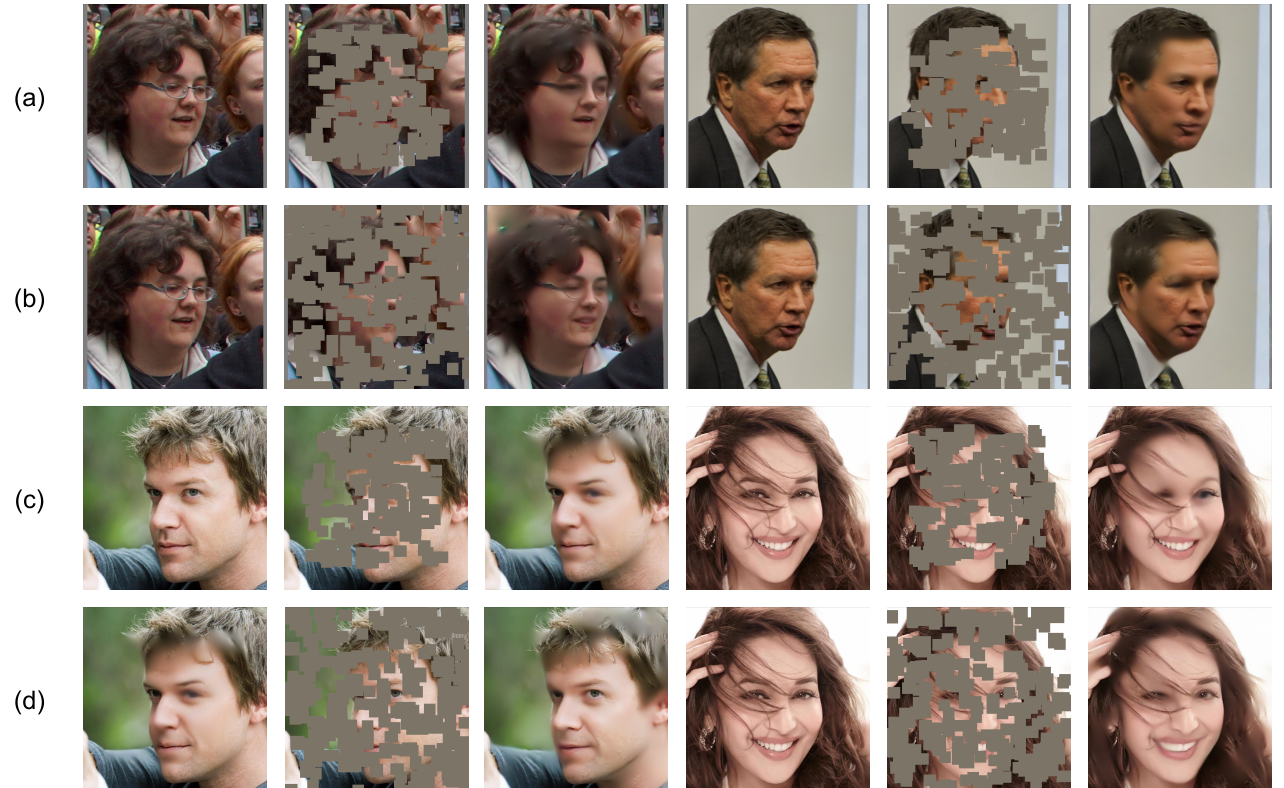
Figure 3. Example reconstruction results on Lapa ( a , b ) and CelebAMask-HQ ( c , d ) images. The first column shows the original images. The second column is the masked images where patches from the center area and the whole area are masked, respectively. The third column shows the corresponding reconstructed